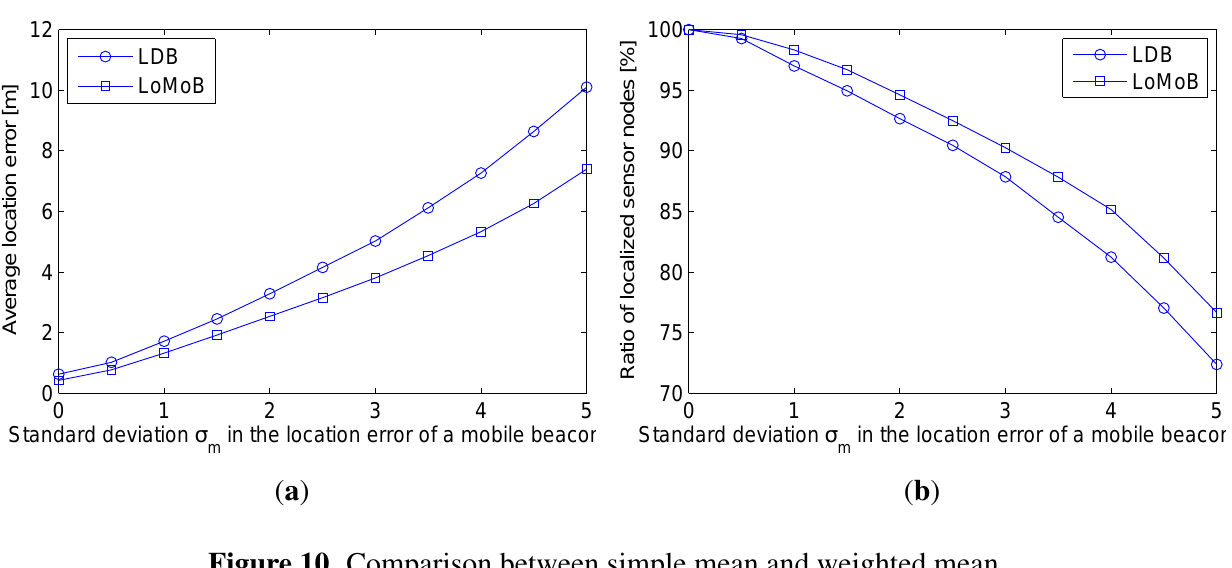
in the location error m